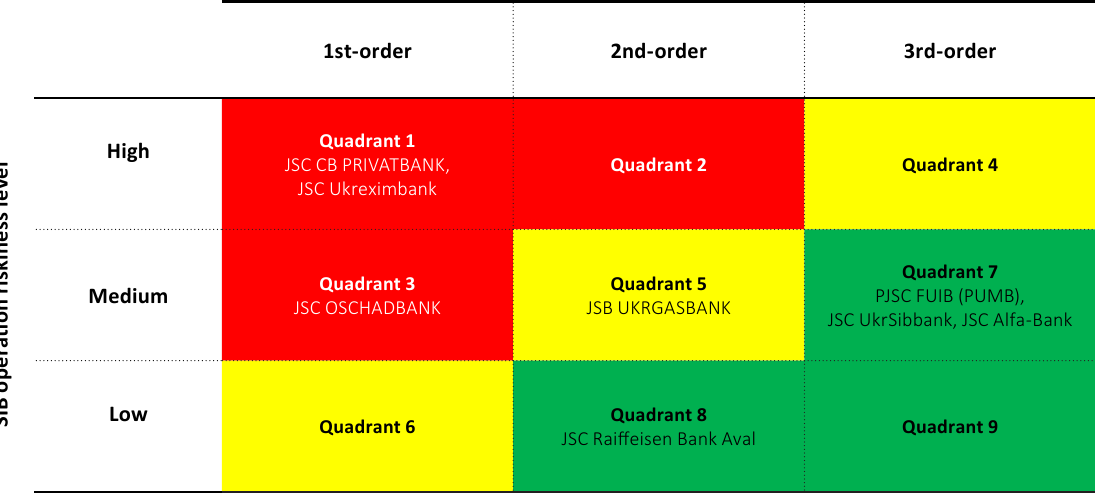
Figure 3. Positioning of the Ukrainian systemically important banks in the matrix “SIB operation riskiness level – Degree of the SIB systemic